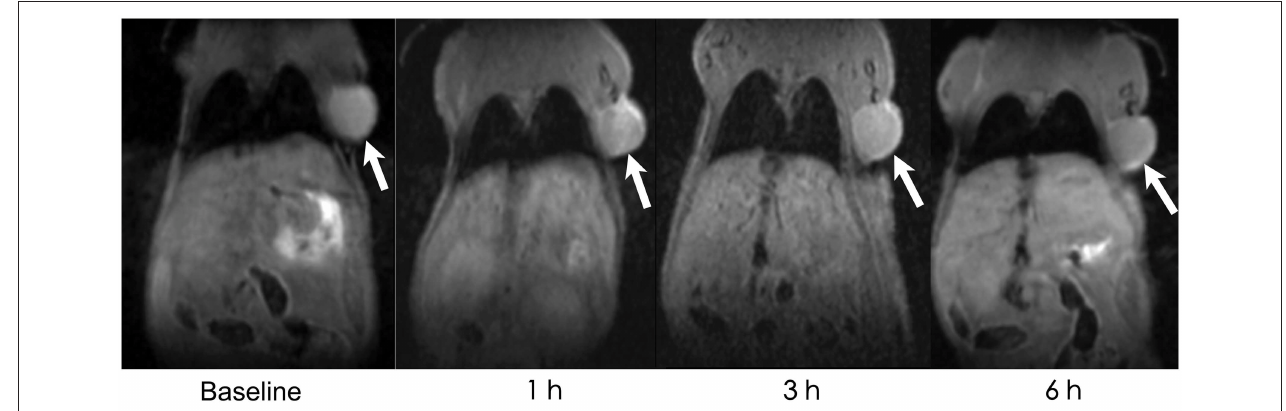
FIGURE 2 | In vivo MRI. In vivo MRI of the HepG2 tumor (white arrow)-bearing mice before AGuIX injection (baseline), 1, 3, and 6h after AGuIX injection through the tail vein.